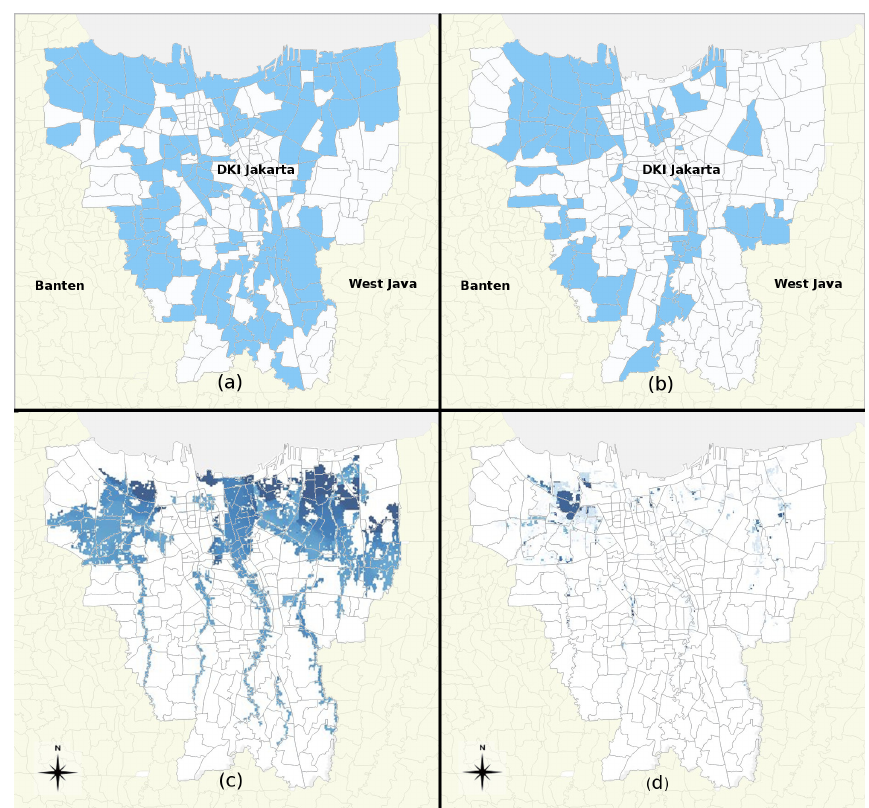
Figure 6. Maps showing Kelurahan (village administration units) in which part of the village administration unit was reported to be inun- dated in the (a) 2007 and (b) 2013 floods. These maps were reported to the National Disaster Management Office (BNPB) by the village administrator. The estimated return periods of the flood events in 2007 and 2013 are 50 and 30 respectively. Below, the inundation maps from the SOBEK model are shown, based on (c) 2007 schematization and a return period of 50 years, and (d) 2013 schematization and a return period of 25 years.